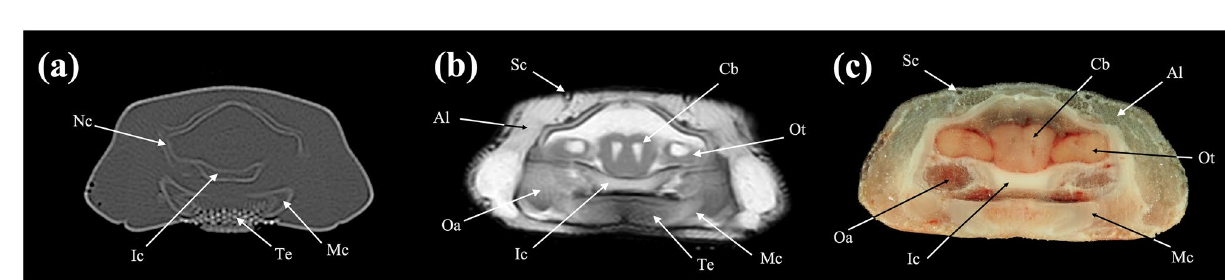
Figure 1. Transverse ( a ) CT, ( b ) MR, and ( c ) cryosection images of a banded houndshark ( Triakis scyllium ) at level 1 of Fig. 25. Al Ampullae of Lorenzini, Ic Internasal cartilage, Mc Meckel’s cartilage, Mt Mandibular teeth, Nc Nasal capsule cartilage, Oa Olfactory lamellae, Ob Olfactory bulb, Os Olfactory sac, Ov Oral cavity, Sc Supraorbital canal.